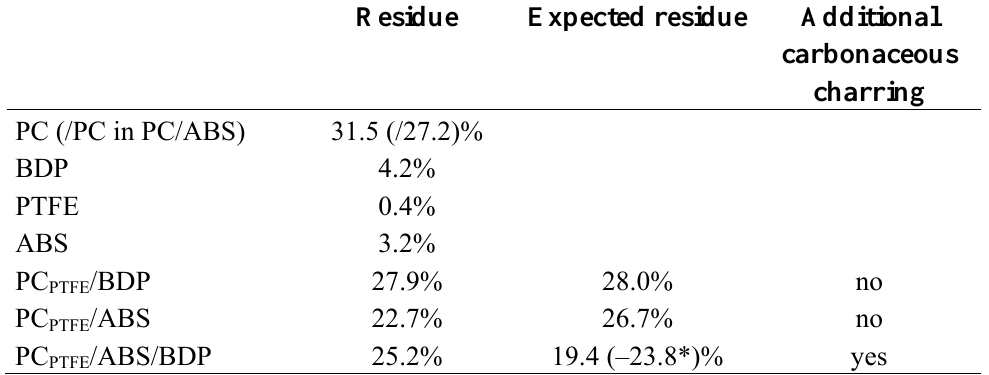
/BDP and PC /ABS/BDP. The residues are PTFE PTFE